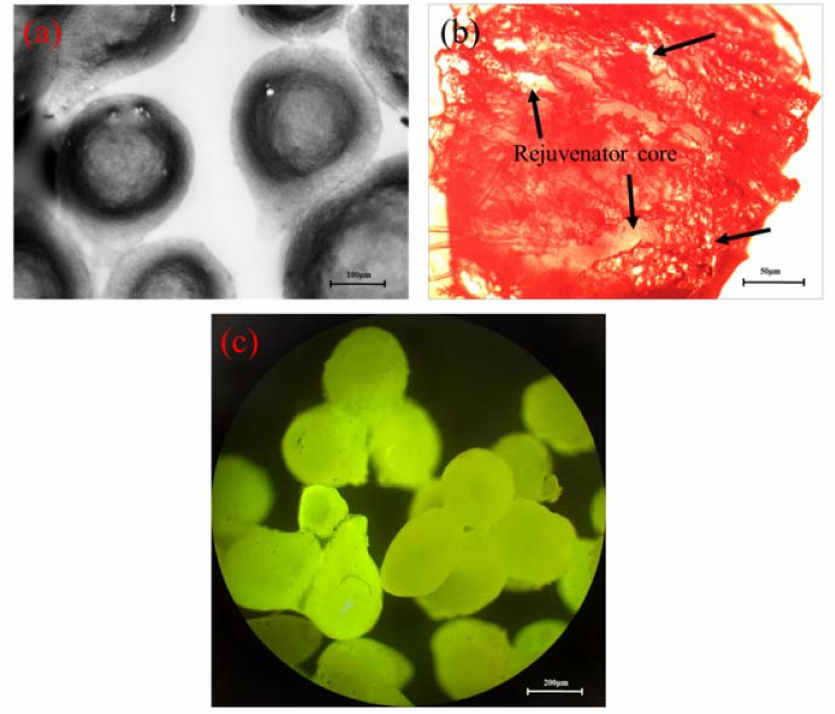
Figure 3. Morphology of the microcapsules ( ϑ o : 3 mL · h − 1 , ϑ e : 5 mL · h − 1 ): ( a , b ) by optical microscope; ( c ) by fluorescence